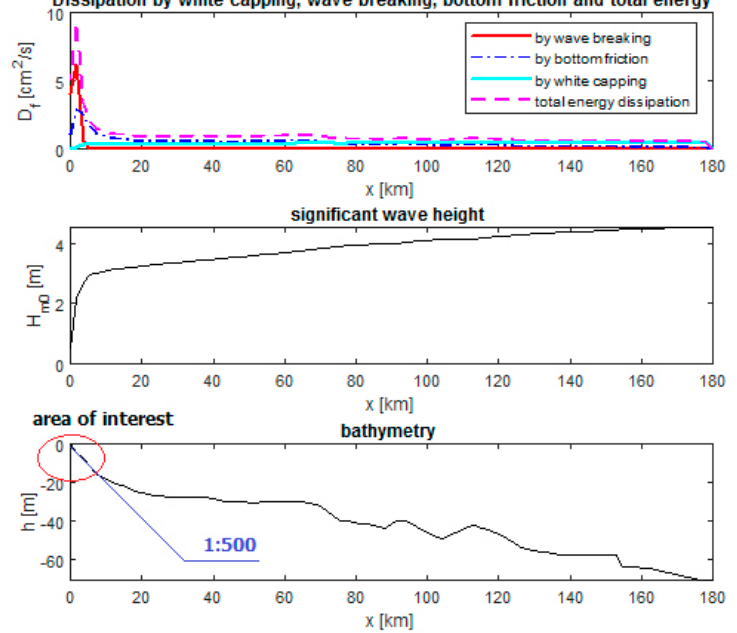
Figure 2. Wave dissipation, significant wave height calculated by SWAN, and bathymetry of the north site with the interested area.